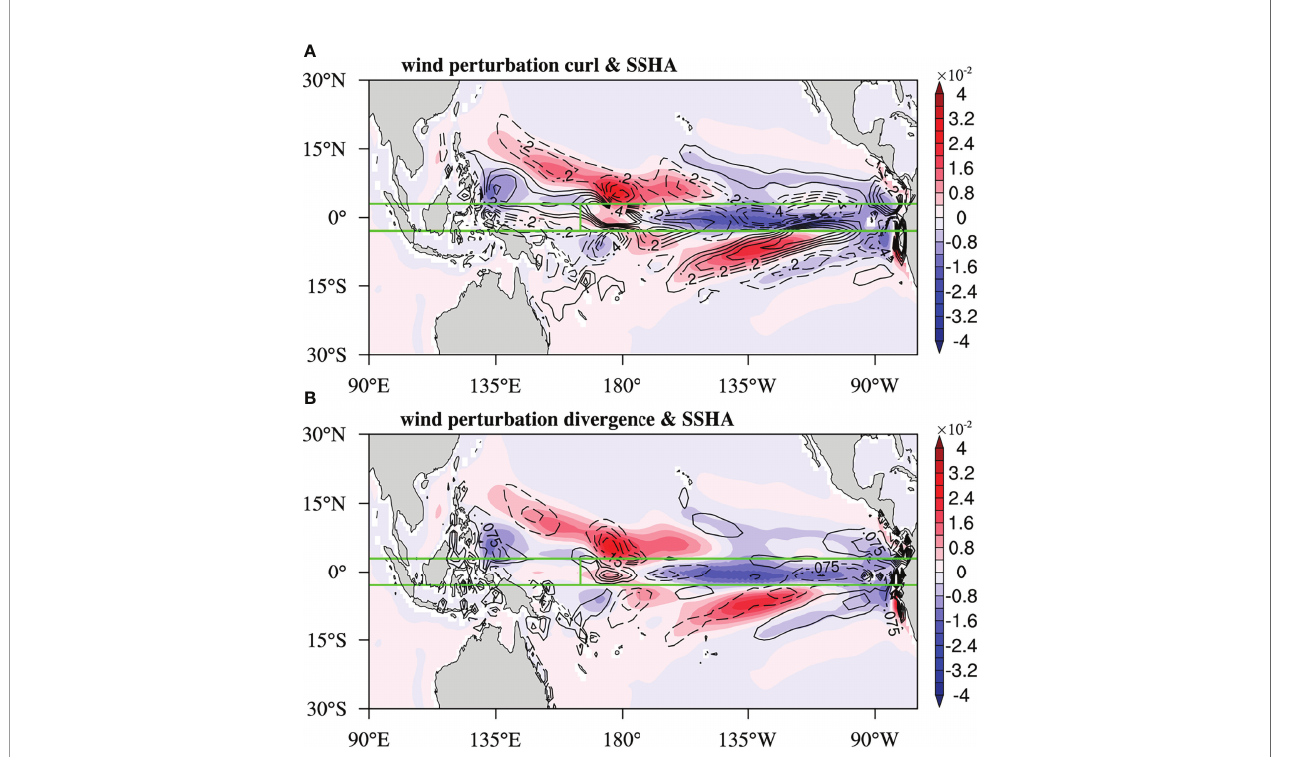
FIGURE 10 | (A) Color shading represents the response of SSHA (m) to sensitive wind velocity perturbation at month – 6, and the contours denote the corresponding wind velocity perturbation curl (10 – 5 s -1 ). (B) same as (A) , but the contours represent the corresponding wind perturbation divergence. The contour interval is 01×10 – 5 s -1 in (A) , and 0.0375×10 – 5 s -1 in (B) . In addition, the level green lines correspond to ±3°, and the vertical green line represents the target